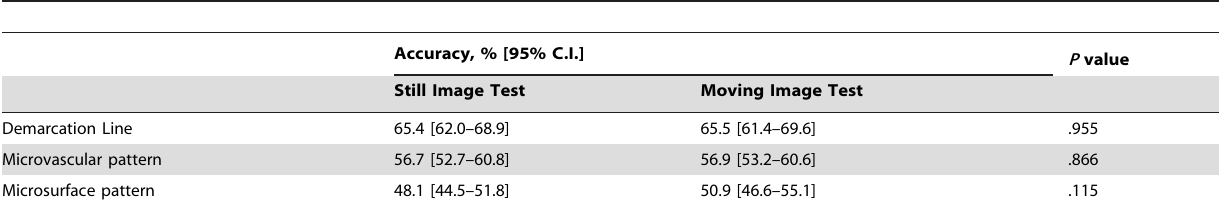
Table 5. Diagnostic Accuracy of Vessels Plus Surface Classification System in Still Image Test versus Moving Image Test by All 34 Endoscopists.